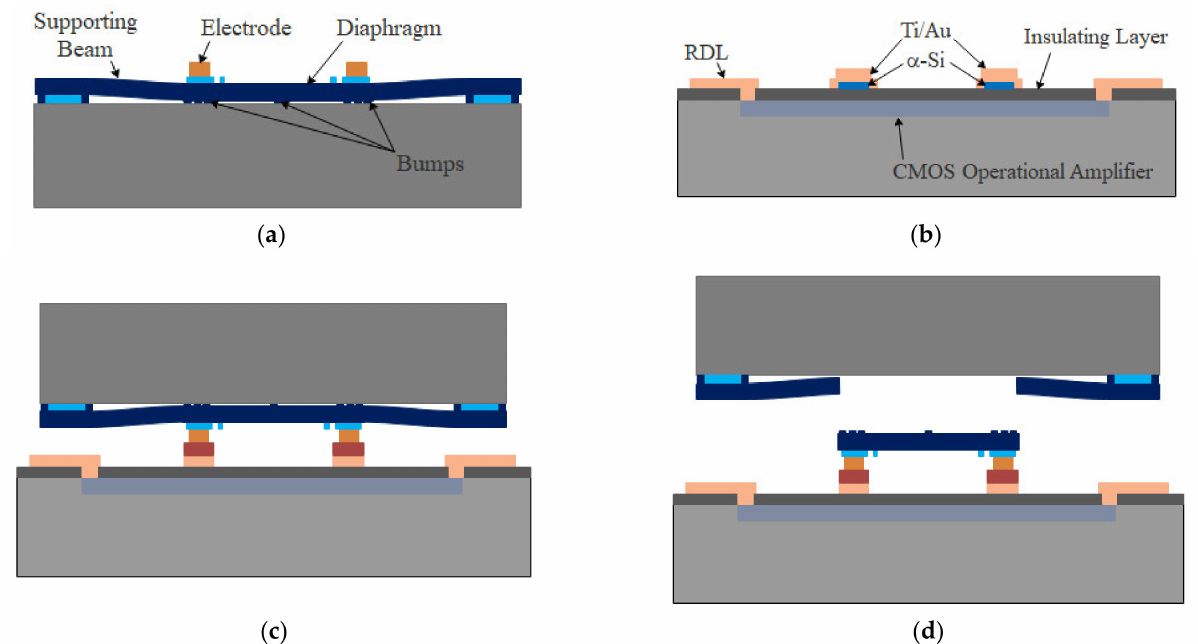
Figure 1. Design process flow of the integrated normal force sensor using stiction effect temporary handling (SETH). ( a ) Normal force sensor is fabricated and temporarily attached to the substrate through the stiction effect; ( b ) readout circuit chip is redistributed, and the pads for eutectic bonding are fabricated; ( c ) normal force sensor is bonded to the readout circuit chip; ( d ) diaphragm is transferred to the readout circuit chip after being pulled off from the substrate and broken from the suspension beams.